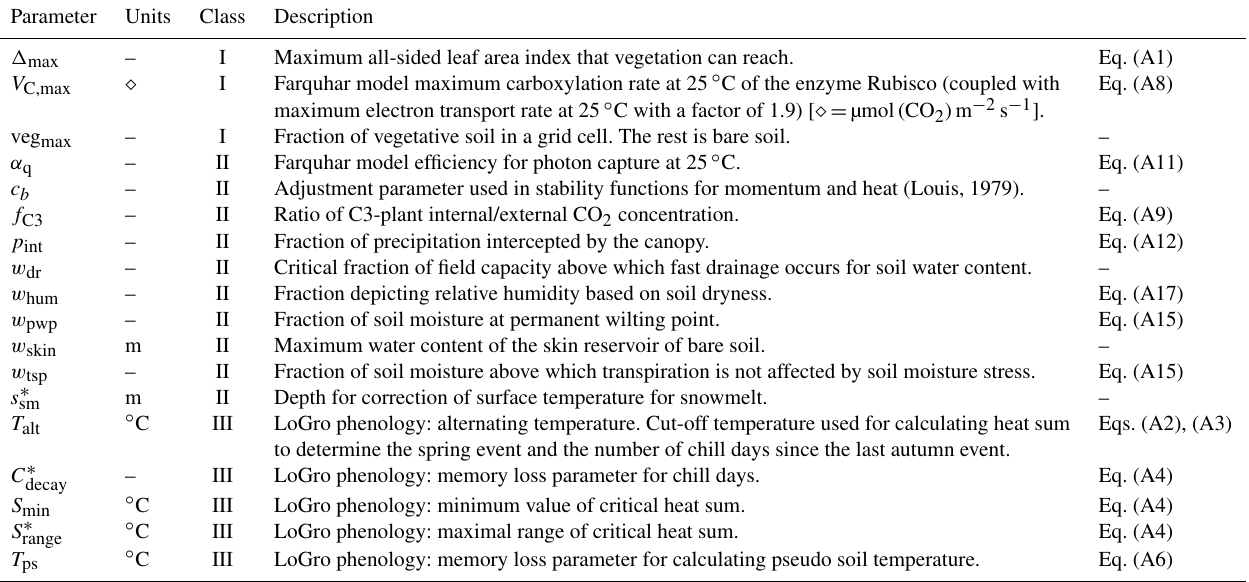
Table 1. Parameter descriptions with references to equations in Appendix A.